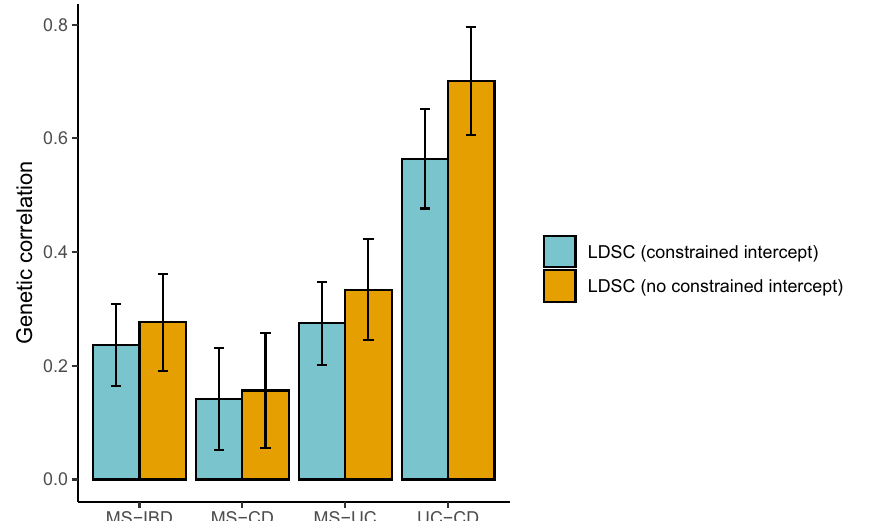
Fig. 1 Summary of pairwise genetic correlations estimated using linkage disequilibrium score regression (LDSC) with and without constrained intercept. Bars represent the point estimates of genetic correlation for each disease pair. Error bars represent the 95% con fi dence intervals (CIs) of the estimated genetic correlations. See Table S1 for complete LDSC results. MS: multiple sclerosis. IBD: in fl ammatory bowel disease. CD: Crohn ’ s disease. UC: ulcerative colitis. Source data are provided with this